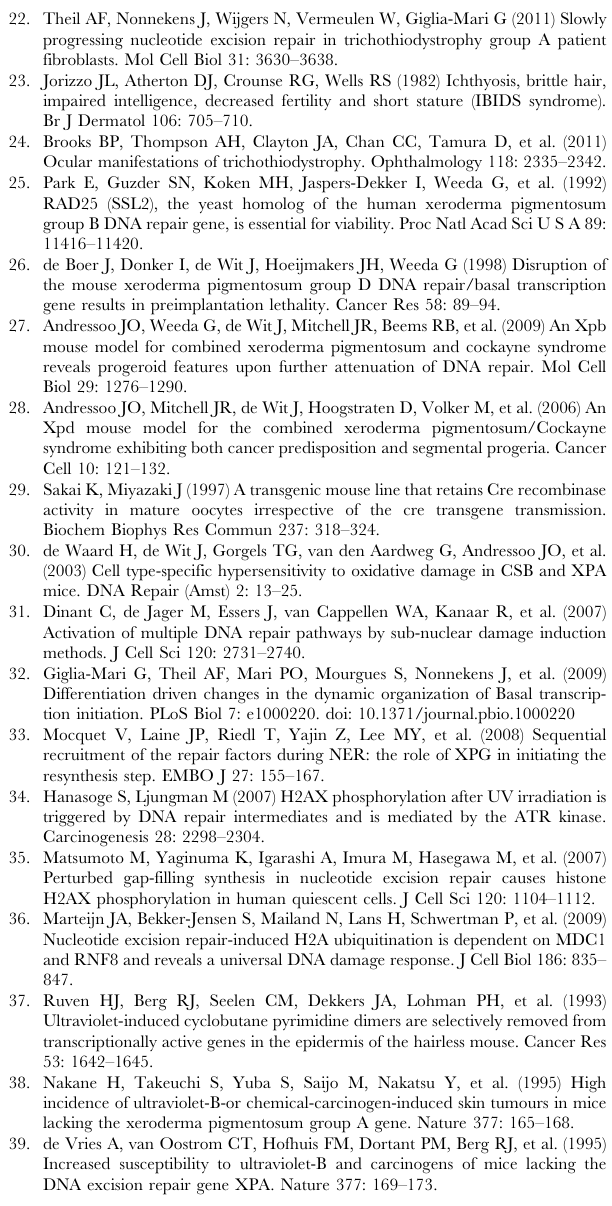
Figure S5 Proliferation assay and gene expression levels of BER genes. (A) Equal number of cells (1 6 10 4 ) were plated on 6 cm culture dishes in triplicate (day 0). The total number of cells was counted in wild-type (n= 2), Ttda + / 2 (n =2) and Ttda 2 / 2 (n= 2) MEFs at different days after seeding. The error bars indicate the SEM. (B) Relative expression levels of mRNAs encoding Apurinic- apyrimidinic endonuclease 1 ( Apex1 ), Flap structure-specific endonuclease 1 ( Fen1 ), Ligase III ( Lig3 ), Poly [ADP-ribose] polymerase 1 ( PARP1 ), DNA polymerase beta ( PolB ) and X-ray repair cross-complementing protein 1 ( Xrcc1 ) in wild-type (n= 8) and Ttda 2 / 2 (n= 8) 11.5-days-old embryos as determined by quantitative RT-PCR. The levels were normalized to Gapdh and the error bars indicate SEM between experiments. (TIF) Table S1 Genotyping of the offspring from matings of Ttda + / 2 LNL mice. Genotyping of offspring from matings of